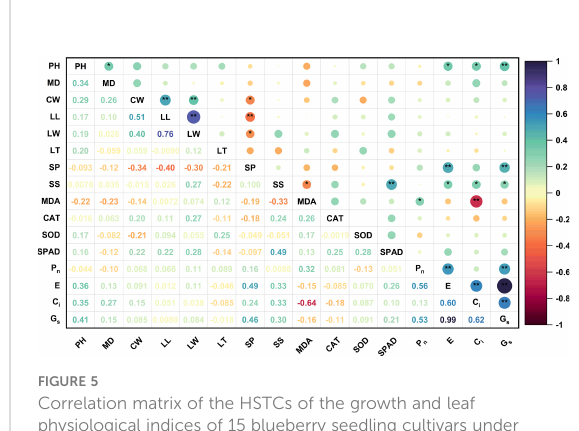
FIGURE 5 Correlation matrix of the HSTCs of the growth and leaf physiological indices of 15 blueberry seedling cultivars under high soil pH stress. The results were derived from the Pearson correlation analysis. PH, plant height; MD, main stem diameter; CW, crown width; LL, leaf length; LW, leaf width; LT, leaf thickness; SP, soluble protein; SS, soluble sugar; MDA, malondialdehyde; SOD, superoxide dismutase; CAT, catalase; SPAD, chlorophyll relative content; P n , net photosynthetic rate; E, transpiration rate; C i , intercellular CO 2 concentration; G s , stomatal conductance. The circle size and color intensity are proportional to the value of each correlation coef fi cient. Positive and negative correlations are displayed in purple and red, respectively. * represents a signi fi cant correlation at the 0.05 level, and ** represents a signi fi cant correlation at the 0.01